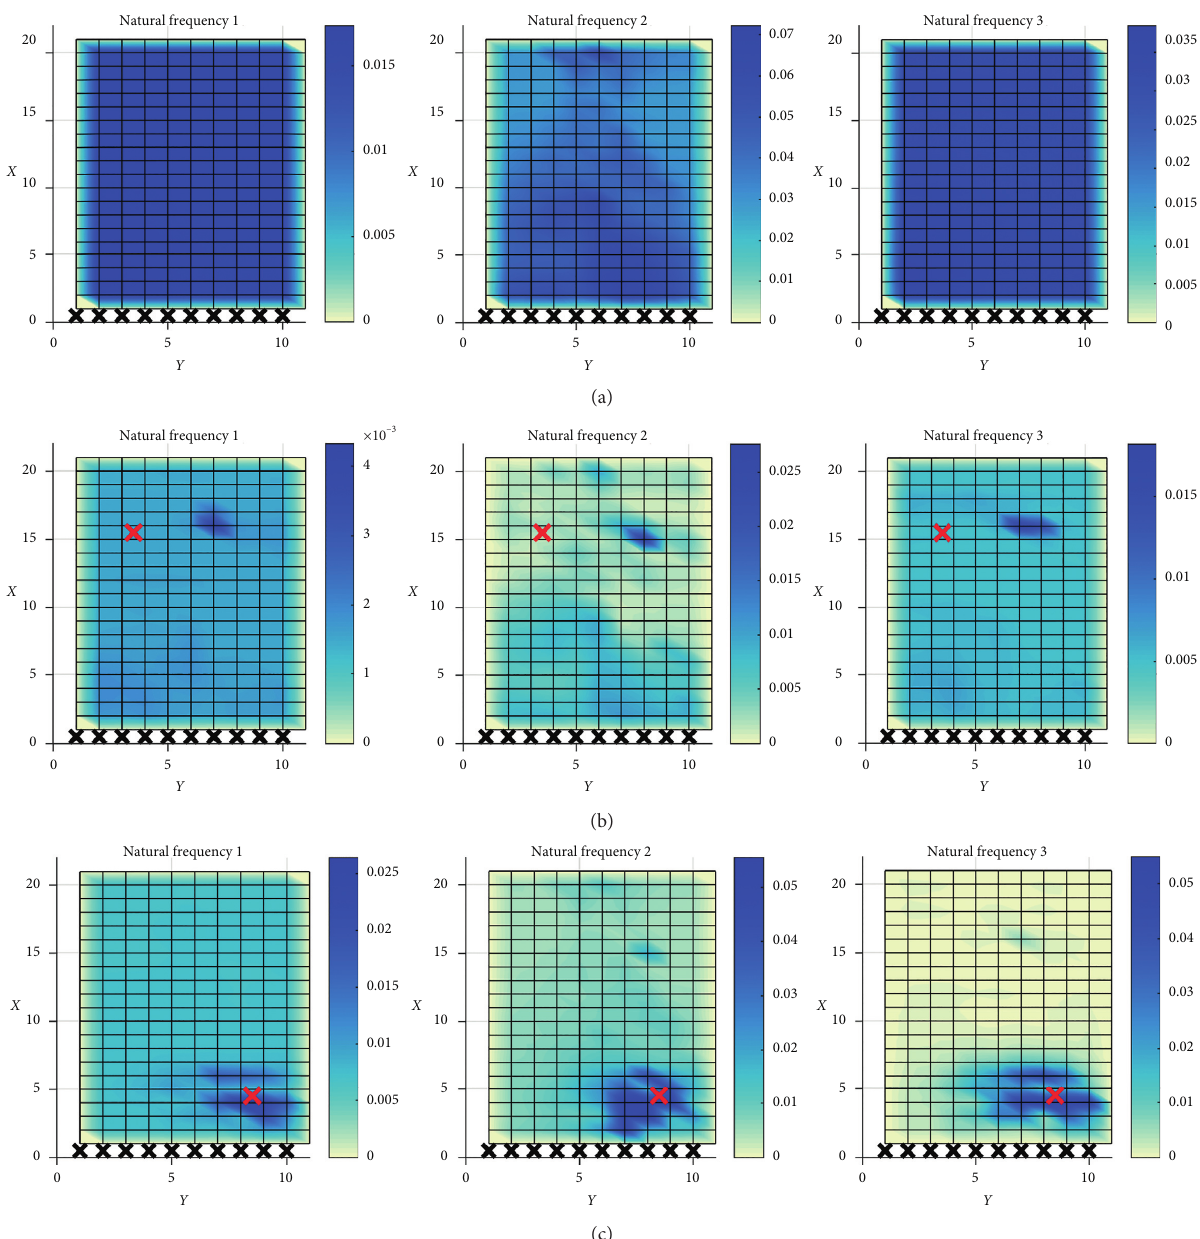
Figure 6: LMF-based damage detection for (a) S#7, (b) S#11, and (c) S#15 case. Black X marks refer to fix. Red X marks refer to damage